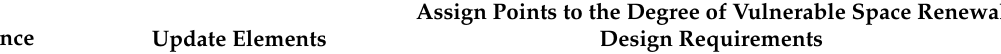
Table 2. Sequence and assignment of elements for sustainable renewal of vulnerable